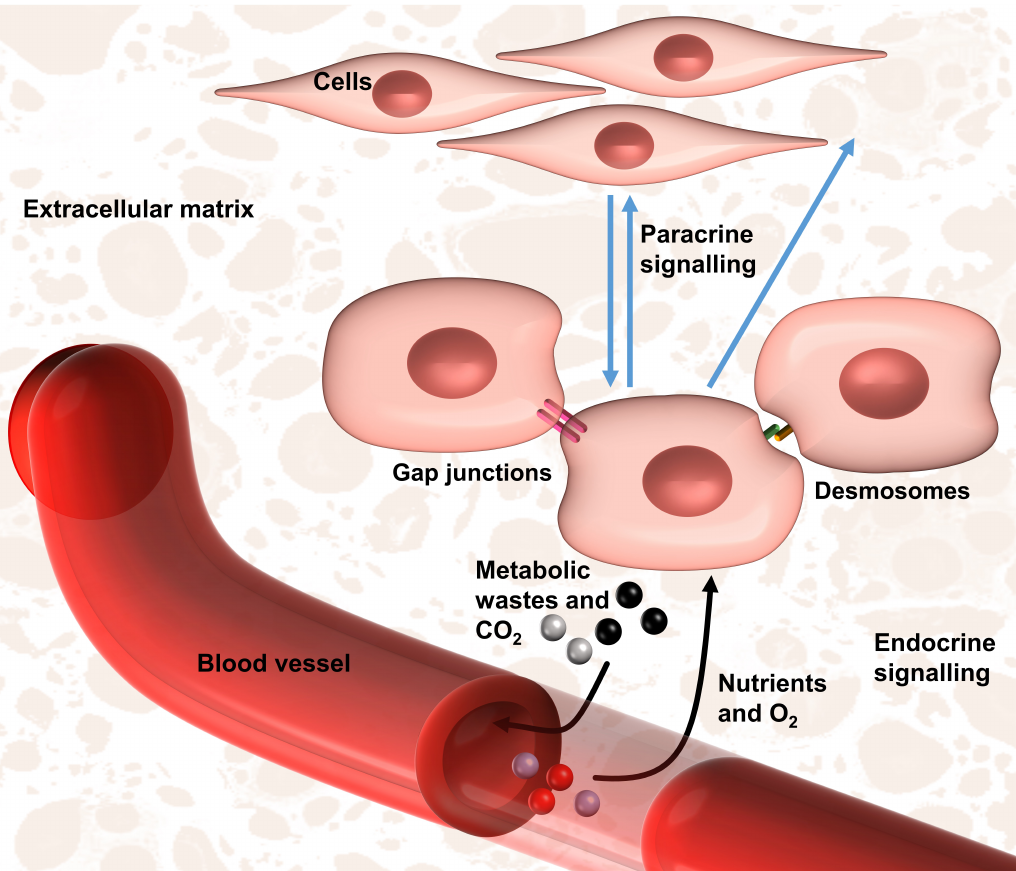
Figure 3. The native cell niche that is intended to be mimicked by developmental engineering. The cells are supplied with oxygen (O 2 ) and nutrients, while their metabolic wastes and carbon dioxide (CO 2 ) are removed via the enclosed vasculature. The cell behaviours are regulated by neighbouring cells via gap junctions or desmosomes, and by distant cells via paracrine signalling or vasculature-mediated endocrine signalling. The cells are also influenced by cell–extracellular matrix